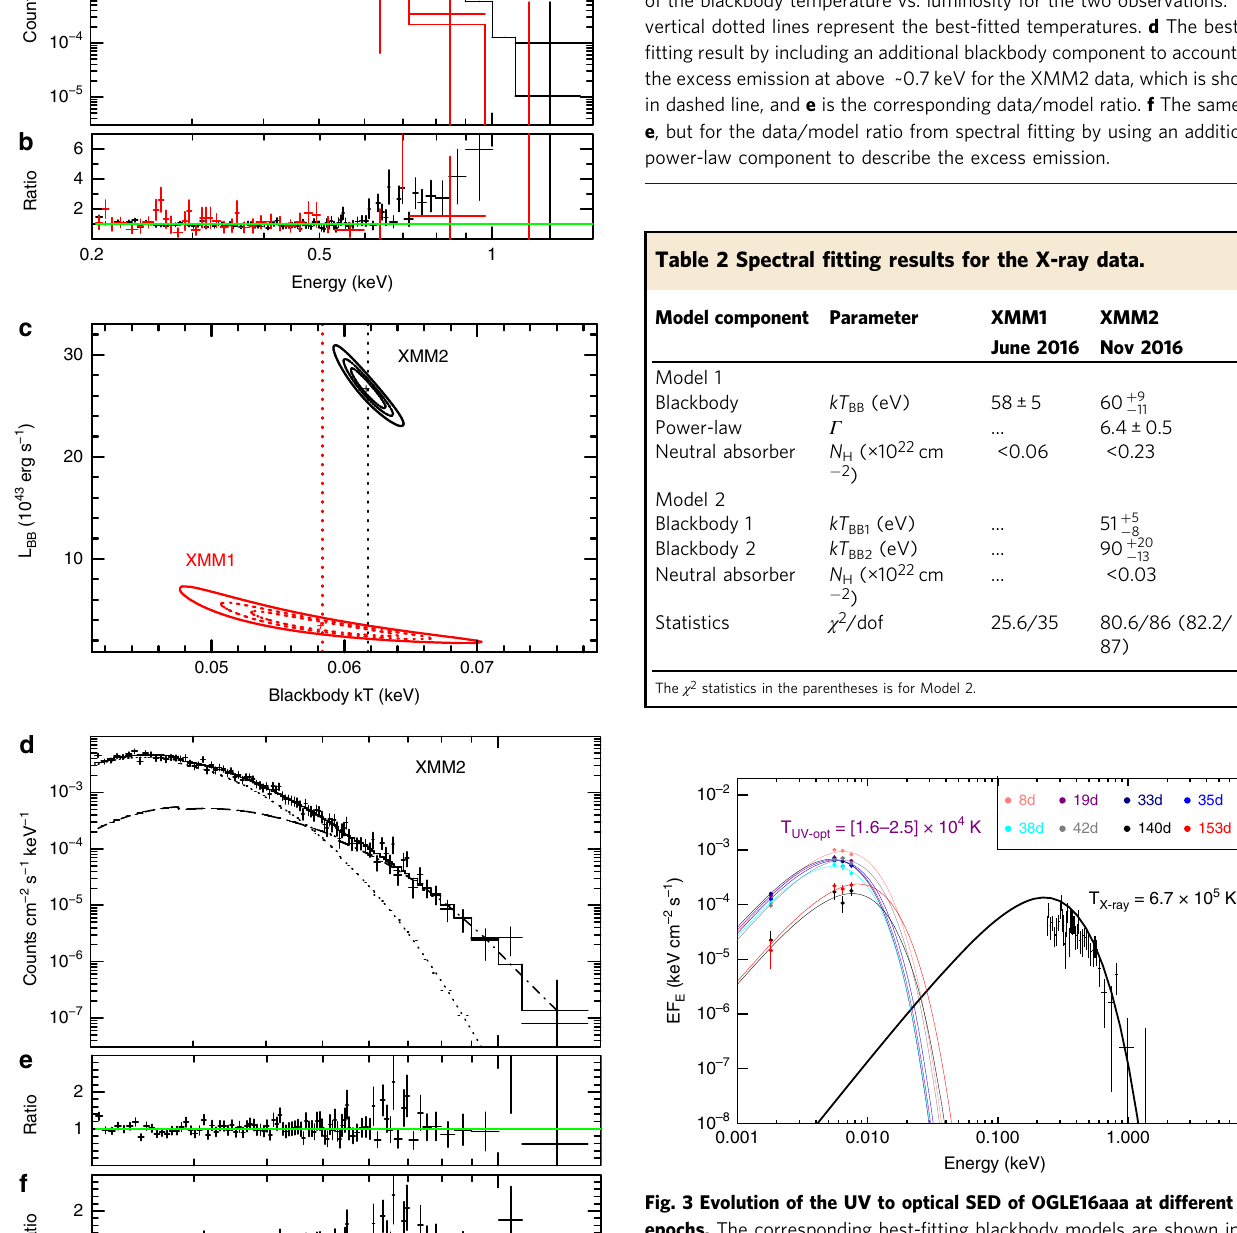
Fig. 3 Evolution of the UV to optical SED of OGLE16aaa at different epochs. The corresponding best- fi tting blackbody models are shown in different colors (noted in the legend), with temperatures in the range [1.6 − 2.5] × 10 4 K. The epochs refer to the time relative to the initial optical peak, in units of days (d). The quasi-simultaneous X-ray spectrum observed with XMM-Newton (XMM1) about 140 days after the initial optical peak is shown in black, which can be fi tted with a single blackbody model of kT BB = 58 eV ( T X-ray = 6.7 × 10 5 K) modi fi ed by Galactic absorption (see text). Error bars represent 1 σ uncertainties that are same as that in Figs. 1 and 2. The unabsorbed blackbody model corrected for Galactic absorption is shown with black curve. Although with a much higher temperature, the best- fi t blackbody to the X-ray data severely underpredicts the UV and optical fl ux, suggestive of different physical